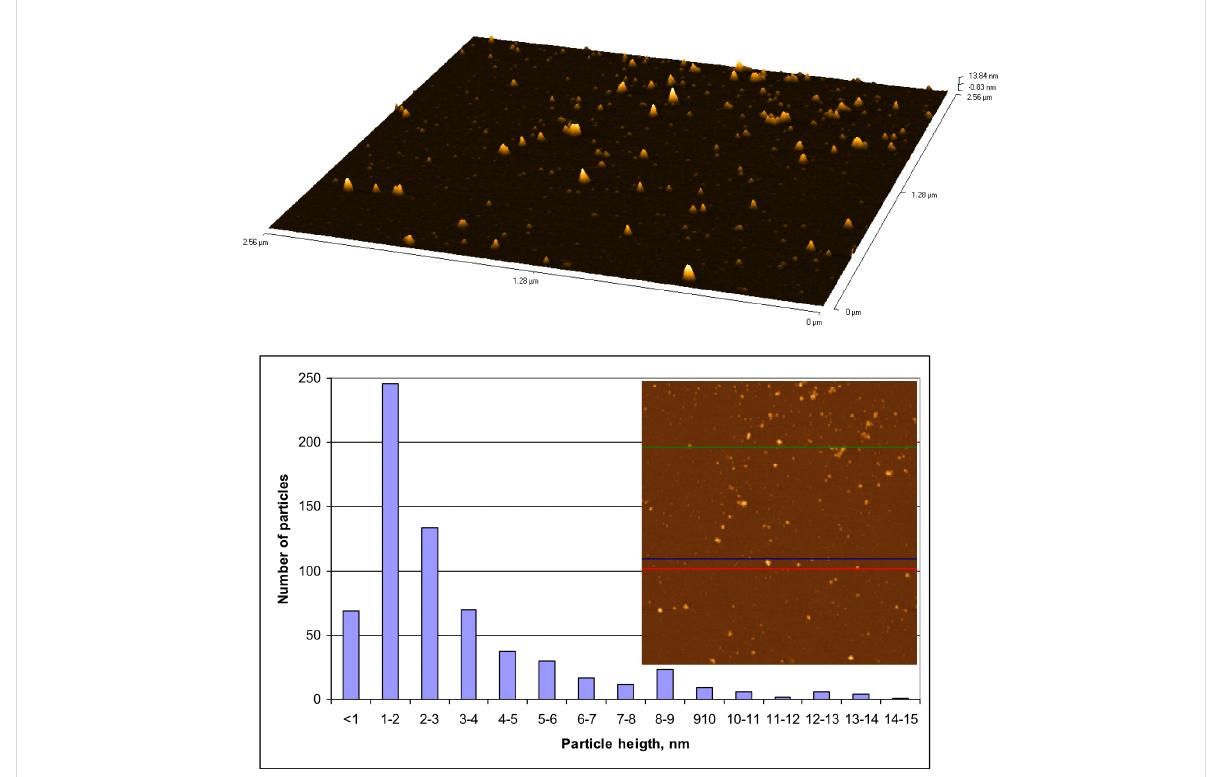
solution, however, a clearly resolved absorption peak at 291 nm is observed. The UV–vis absorption spectrum of the solution containing the gold species collected from the surface of the cobalt ferrite NPs (Figure 3, plot 3) exhibits two absorption shoulders at 522 and 377 nm. The former seems to be